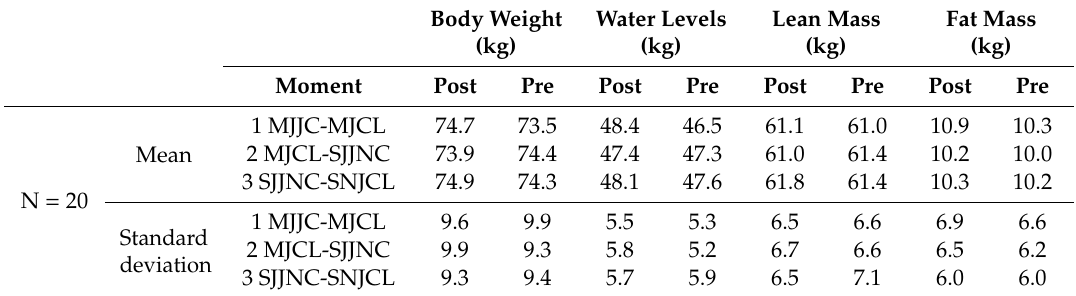
Table 3. Characteristics of the judokas at the di ff erent moments (mean M and standard deviation ± SD) post and pre competition in body weight, water levels, lean mass, and fat